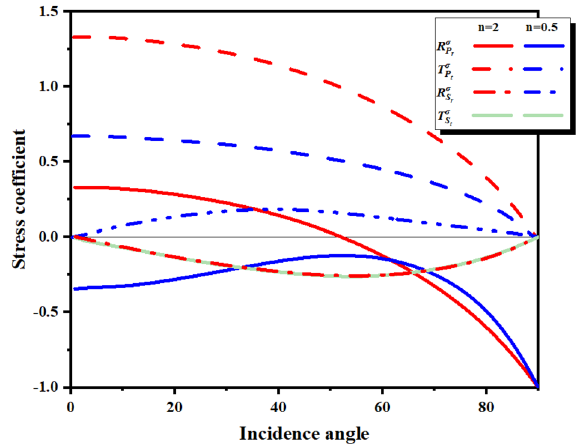
Figure 4. Stress coefficient at different incident angles.